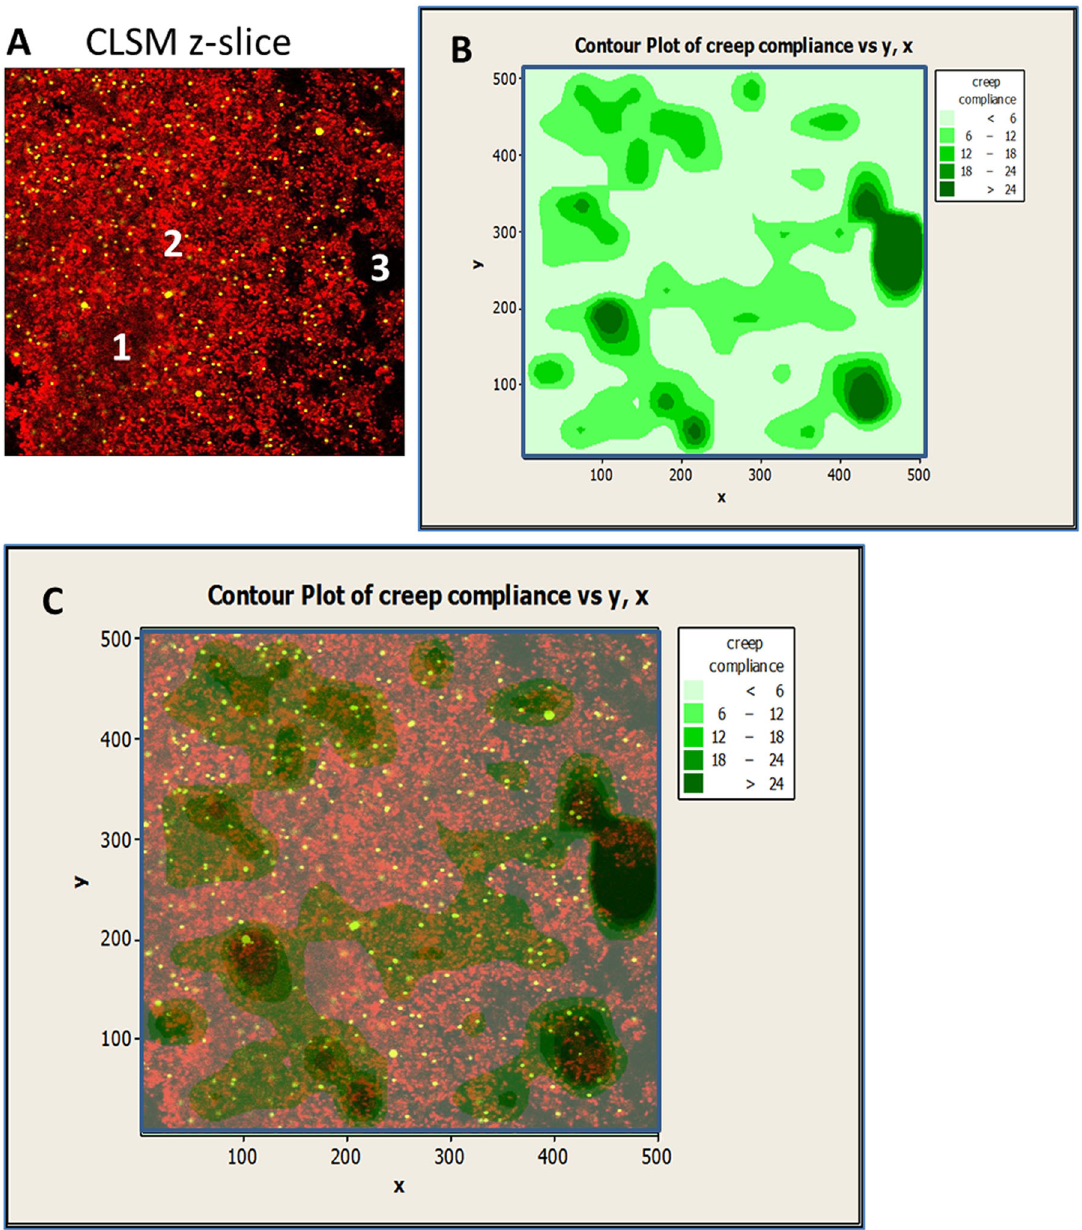
Fig. 5. Region-speci fi c Creep compliance analysis. a Example of a horizontal plane (xy-) micrograph of a bio fi lm layer depicting mCherry- expressing P. fl uoresence cells ( red ) and 1 μ m fl uorescent beads ( green ). Zones 1, 2 identify bio fi lm areas of high low cell density and high cell density respectively. Zone 3 is recognized as surrounding bulk suspension. b Bead trajectories from zones 1 and 2 are used to calculate MSDs used to determine Creep compliance. Akima's polynomial method for the interpolation of creep compliance values for each fl uorescent bead ’ s xy-coordinate was used to generate contour maps. c By merging xy-micrographs and corresponding contour maps, region-speci fi c creep compliance analysis is